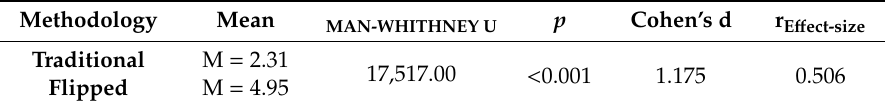
Table 3. Academic performance depending on educational